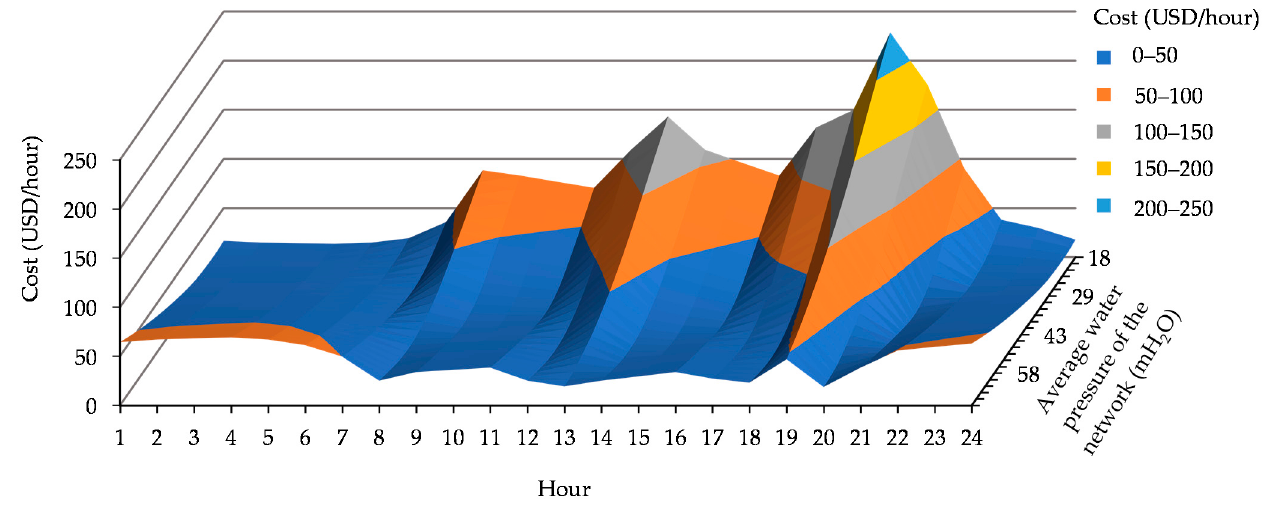
Figure 10. Model results for calculating the optimum average pressure of the network on an hourly basis.